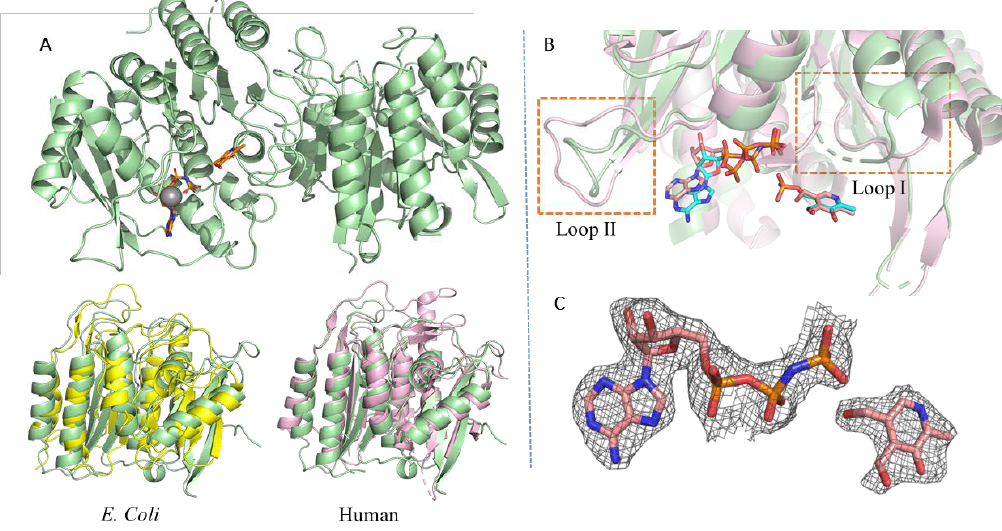
Figure 2. The structure of Pf PdxK loaded with the non-hydrolysable ATP analog (AMP-PNP) and PL (green). ( A ) Structure alignment with PdxK from Human (pink) and E. coli (yellow), respectively, demonstrates the conserved nature of the fold; ( B ) an alignment of AMP-PNP and PL in Pf PdxK (green) with the human complex (pink; 3KEU) with ADP and PLP shown in stick representation, showing the conserved nature of binding of both ATP and the substrate. ( C ) The 2Fo-Fc electron density map for AMP-PNP and PL (black mesh) within the Pf PdxK structure (monomer A) contoured at 1 σ . An omit map is for AMP-PNP and PL is shown in 3B and 3D.